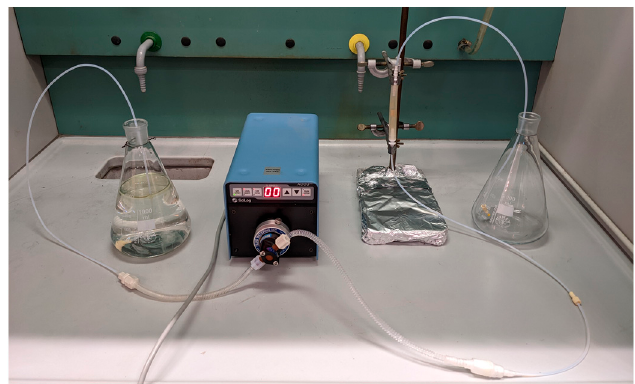
Figure 2. Apparatus used for the sorption in continuous fl ow.